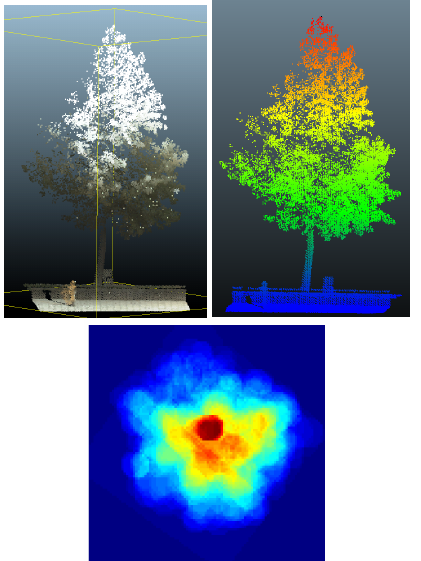
Figure 1: (a) An example tree point cloud from a mobile laser scanning data, (b) The same tree point cloud with height values assigned to the points as false color, (c) The calculated V ( x; y ) matrix is shown with false colors where the red color corresponds to the highest and the blue color corresponds to the lowest value.